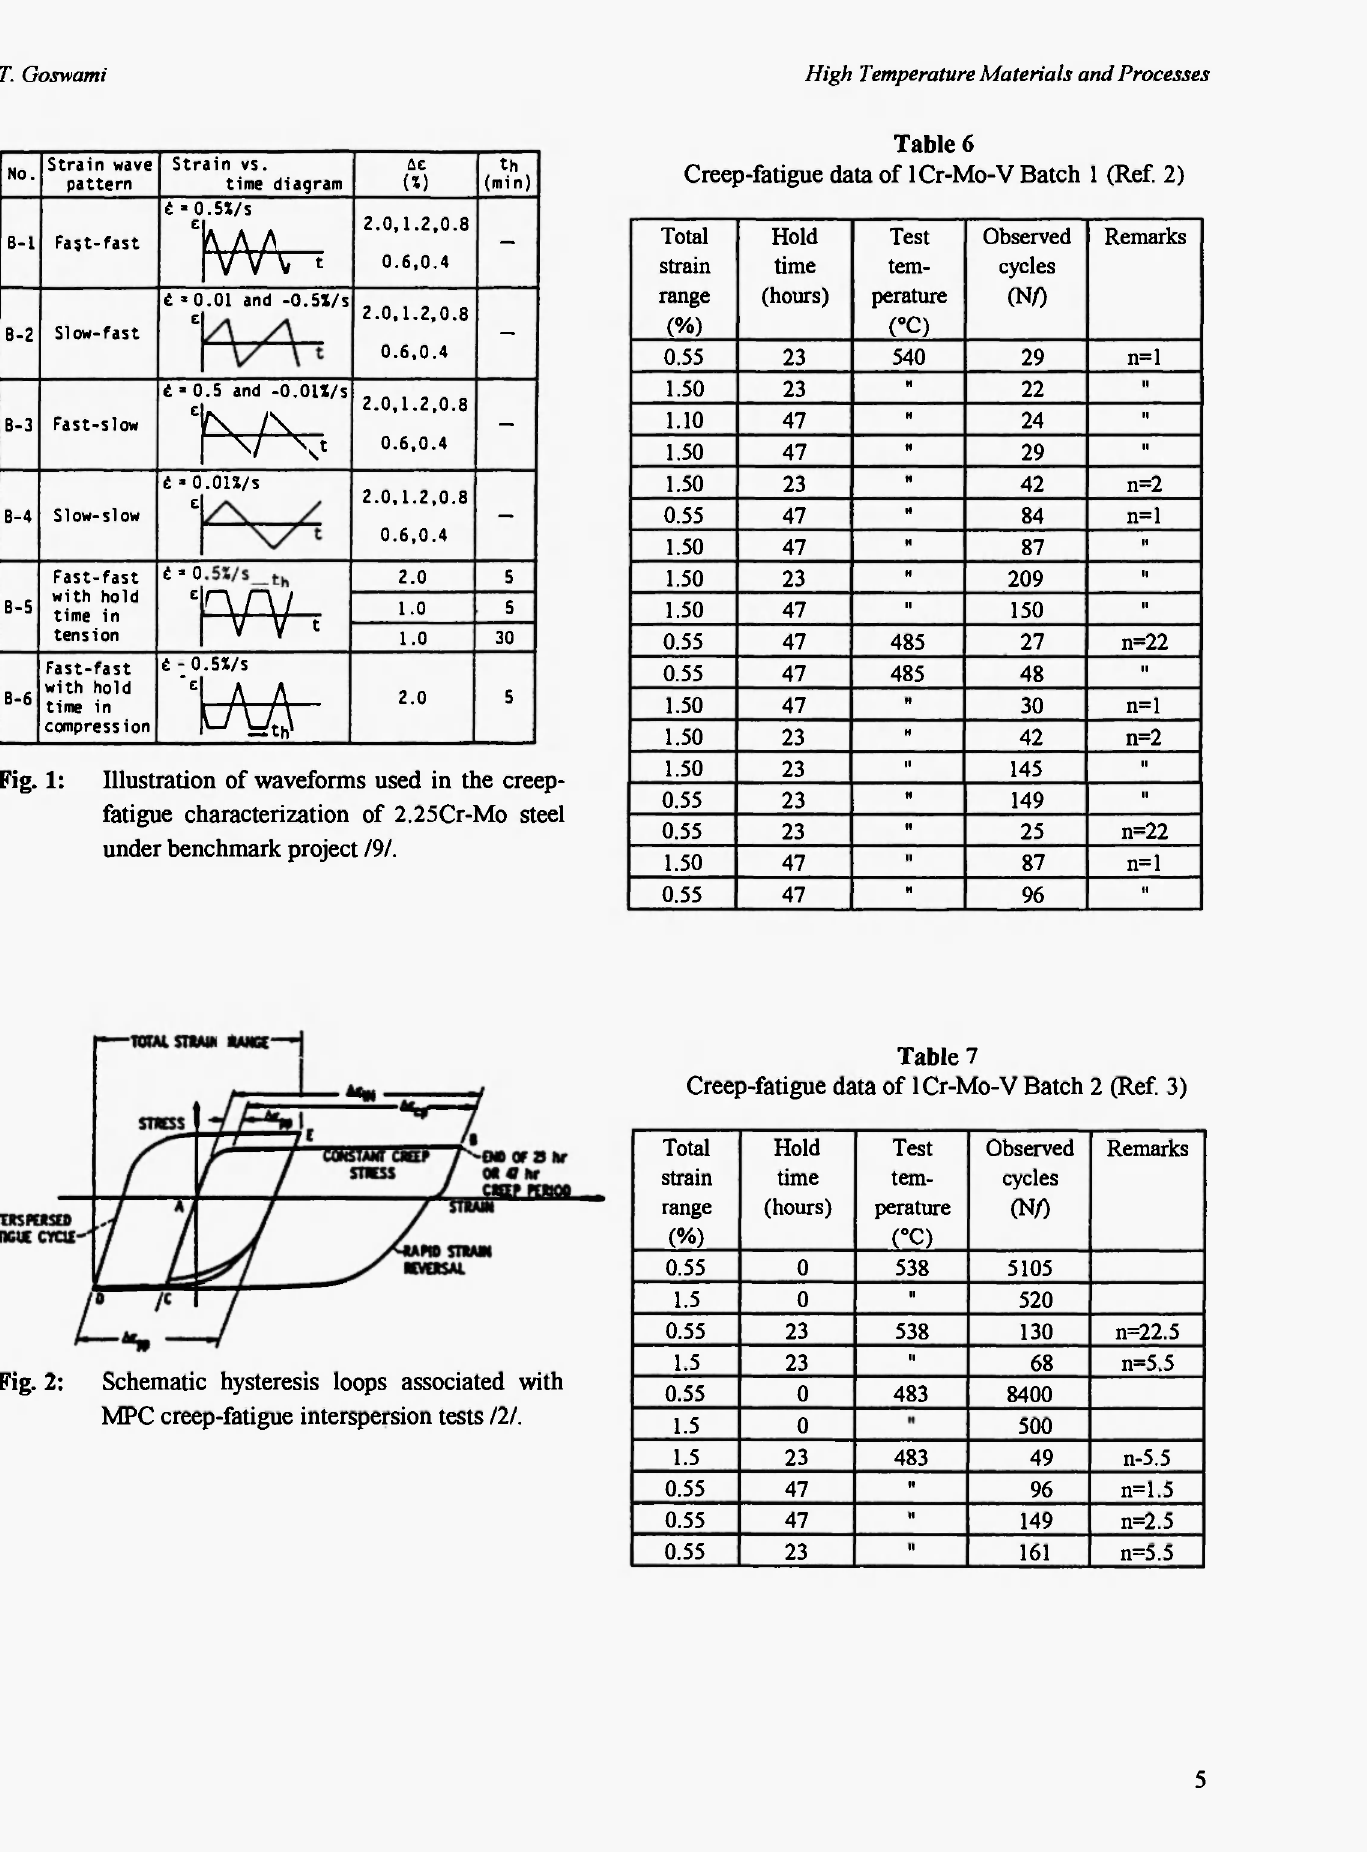
Creep-fatigue data of lCr-Mo-V Batch 2 (Ref.